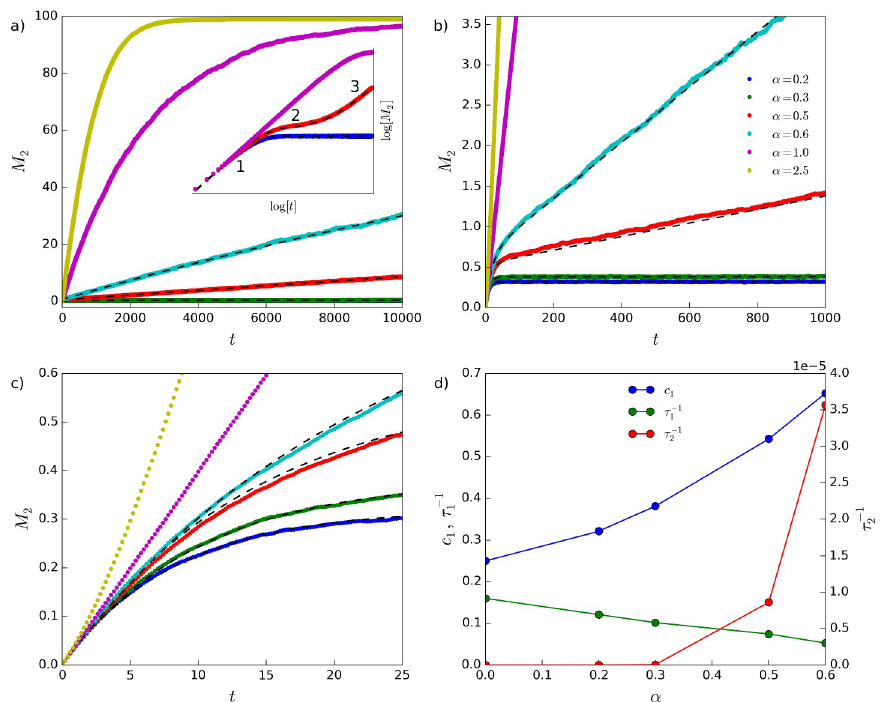
Fig 4. Evolution of M 2 ( t ) for α > 0. Values of α are indicated in the legend in (b), and δ = 0.2 for all curves. (a) shows rapid ascent of M 2 ( t ) to upper plateau value for α = 1.0 and α = 2.5 (main plot), and the inset of (a) shows three of the curves on log-log scale, with stages 1-3 of the evolution of M 2 ( t ) indicated for the α = 0.5 curve. (b) and (c) show the main plot of (a) at different magnifications, to allow inspection of the fit of Eq 7 (dashed black lines) to the curves with shown on righthand side (parameters for α = 0 are from Eq 7, α � 0.6. (d) fit parameters, with y axis scale for t (cid:0) 1 2 assuming τ 2 = 1 ). N = 100, n r =